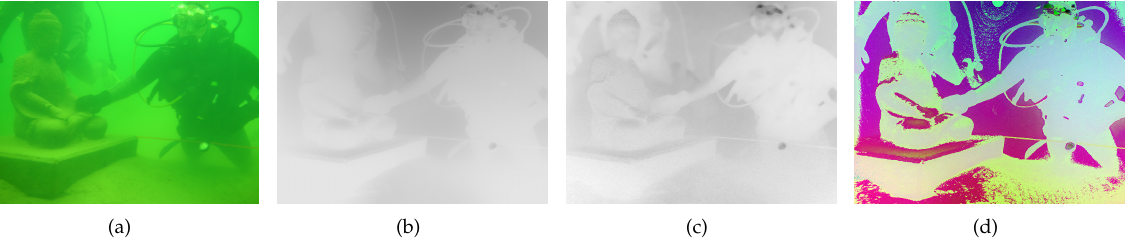
Figure 1. ( a ) An underwater image; ( b ) transmission map estimated by UDCP; ( c ) transmission map estimated by LDCP; ( d ) transmission map estimated by the proposed